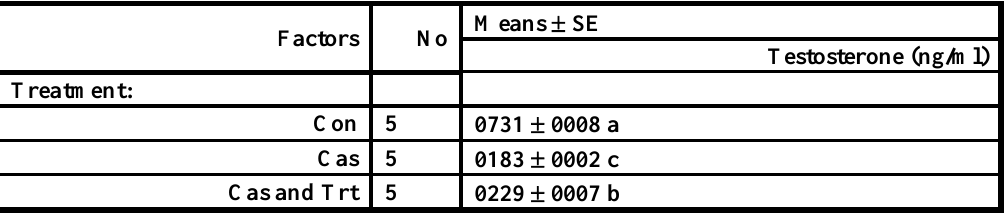
Table 5 Effects of Nigella sativa oil on Testosterone in castrated male rats